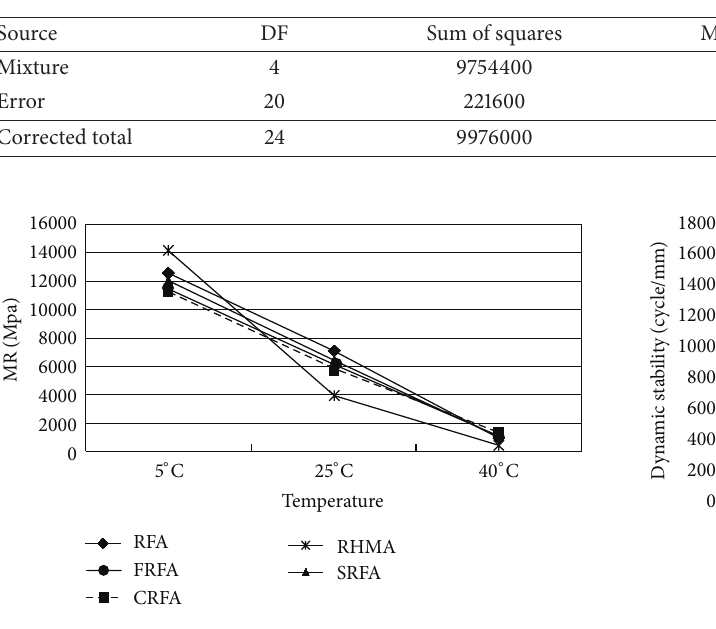
Figure 9: Resilient modulus test results at three different tempera- tures.